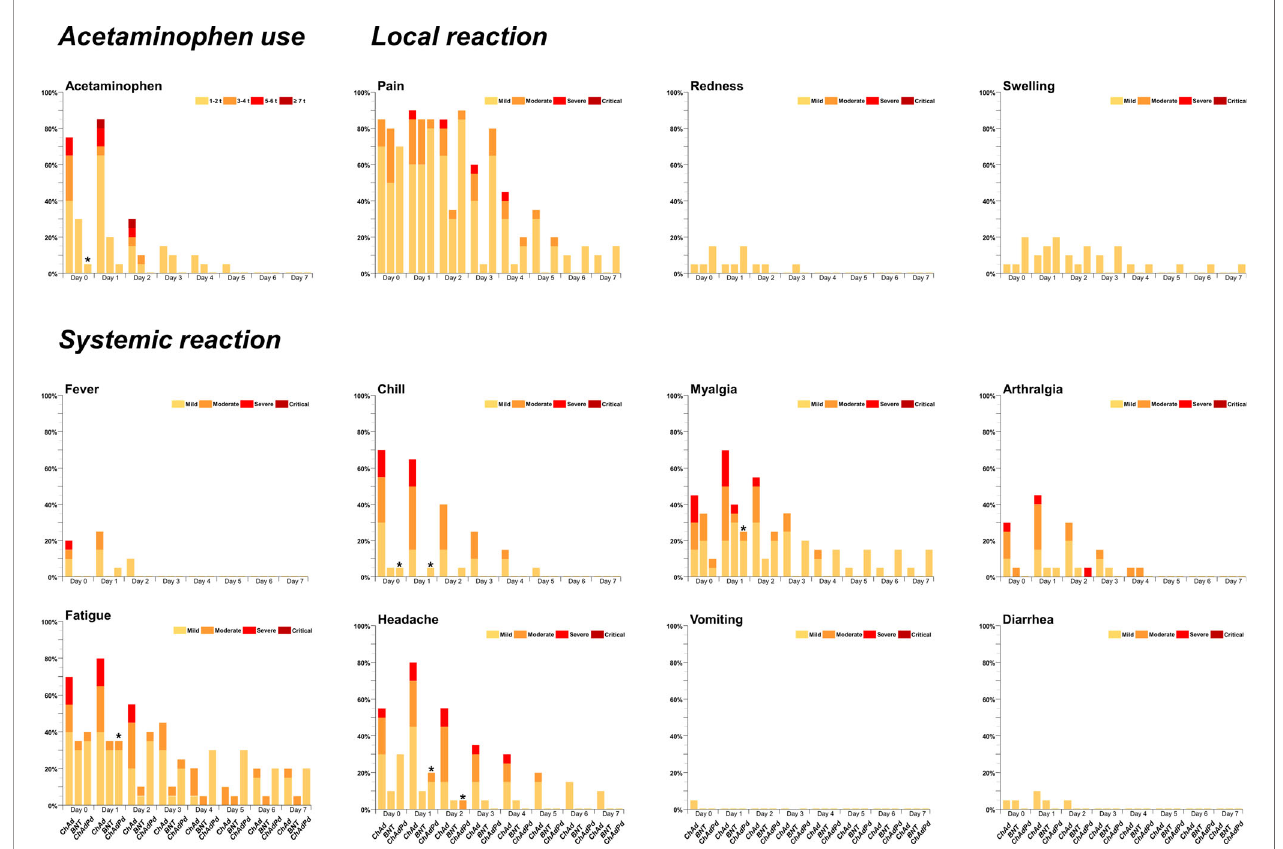
FIGURE 1 | Daily reactogenicity score of the ChAd, BNT, and ChAdPd groups. A total of 11 side effects and the need for AAP to control side effects were investigated and presented as a numeric score of 0 to 4. The asterisk (*) denotes signi fi cantly reduced side effects in the ChAdPd group compared to the ChAd group. HCWs took AAP to control side effects from 1 tablet once a day to 2 tablets three times a day. One HCW ChAd group took 2 tablets four times a day on day 1 and 2 to control severe headache. t, tablet; AAP, acetaminophen; ChAd, ChAdOx1 nCoV-19-vaccinated group; BNT, BNT162b2-vaccinated group; ChAdPd, corticosteroid-exposed ChAdOx1 nCoV-19-vaccinated